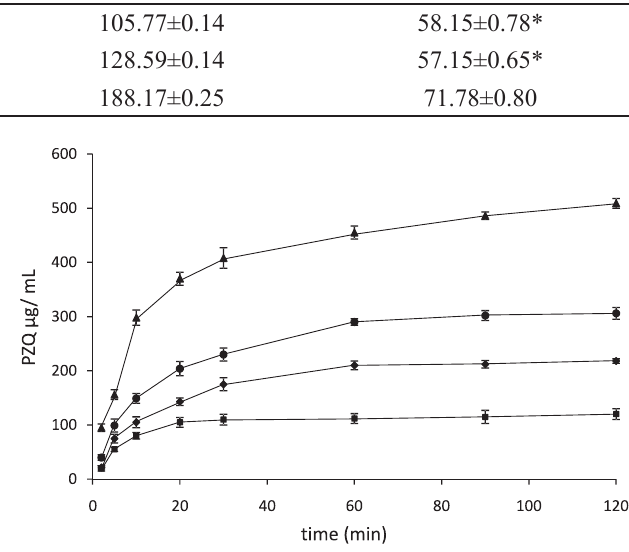
FIGURE 3 - Dissolution profiles of PZQ with CR-60 (CR-60: PZQ - 2:1) in SDs. Co-precipitation (  ), fusion (  ), Physical mixture (  ) and pure PZQ (  ). Each point represents the mean ± standard deviation,